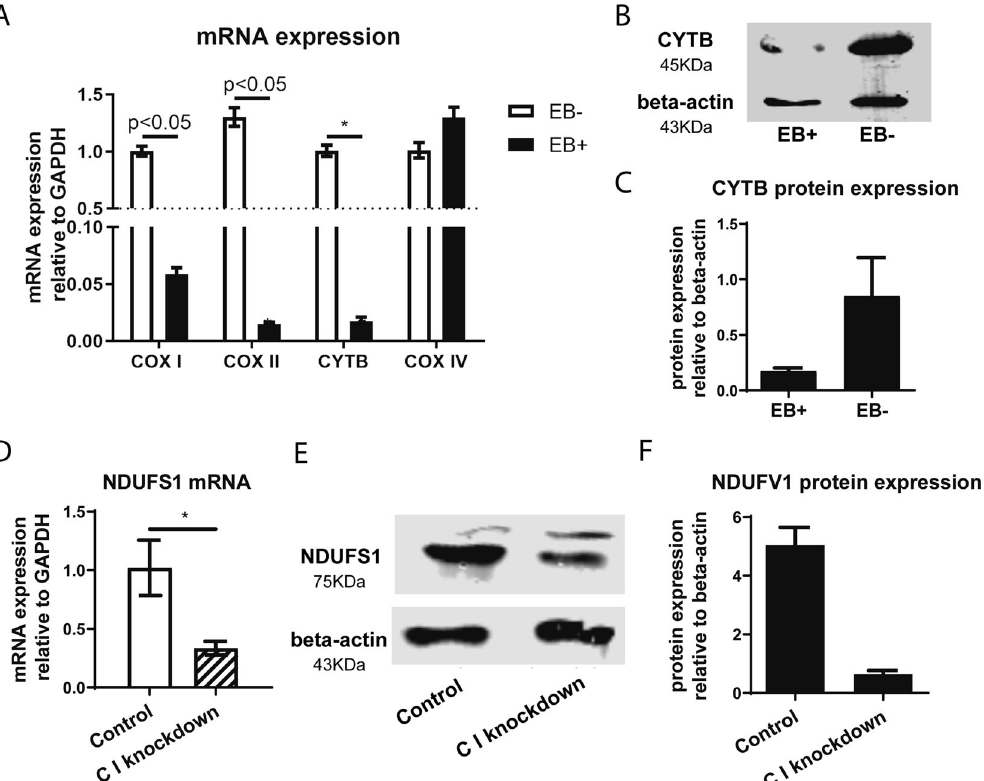
Fig. 3 Establishing the mETC-de fi cient cell models. A – C Real-time PCR analysis of COX I, COX II, COX IV and CYTB mRNA ( A ) ( N = 6) and Western blotting analysis of CYTB protein ( B , C ) ( N = 3) in HCC cells after treatment with EB for 5 days. D – F Real-time PCR analysis of NDUFS1 mRNA ( D ) ( N = 6) and Western blotting analysis of NDUFS1 protein ( E , F ) ( N = 3) in HCC cells after transfected with NDUFS1 lentivirus. Results are presented as mean ± SD, group differences were tested by Mann – Whitney U